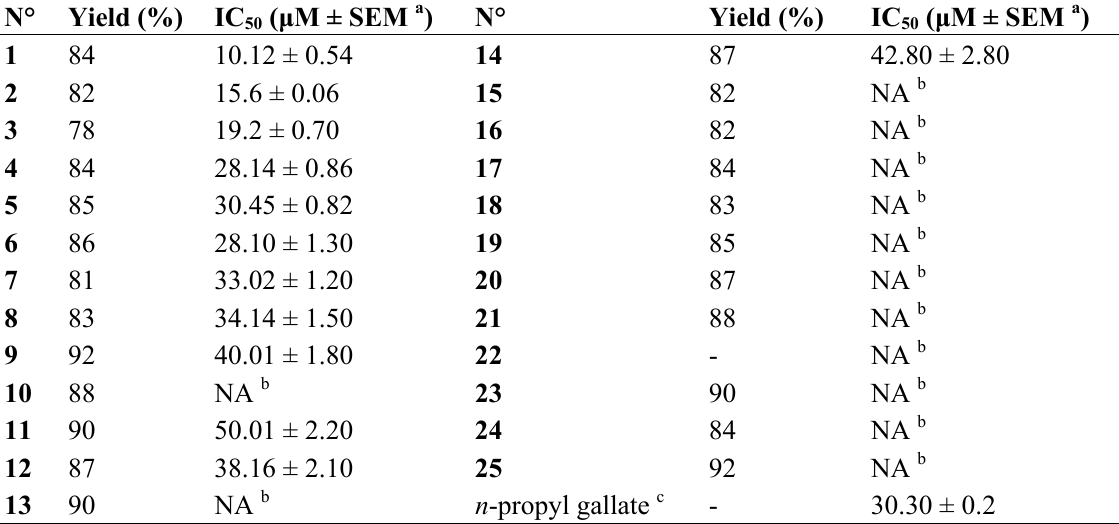
Table 1. In vitro DPPH activity and % yield of compounds 1 – 25